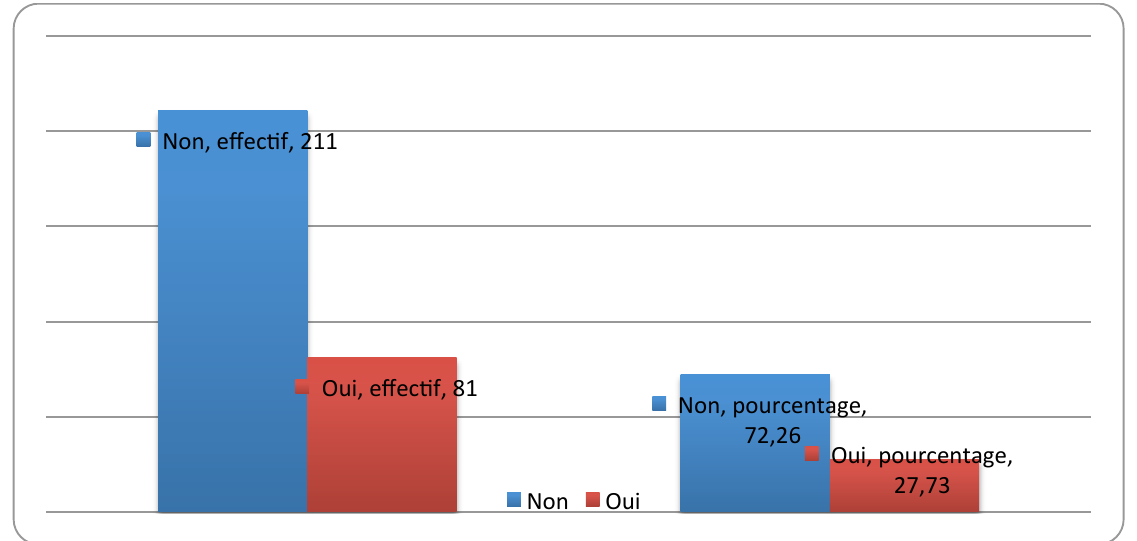
Figure 7. Choix de